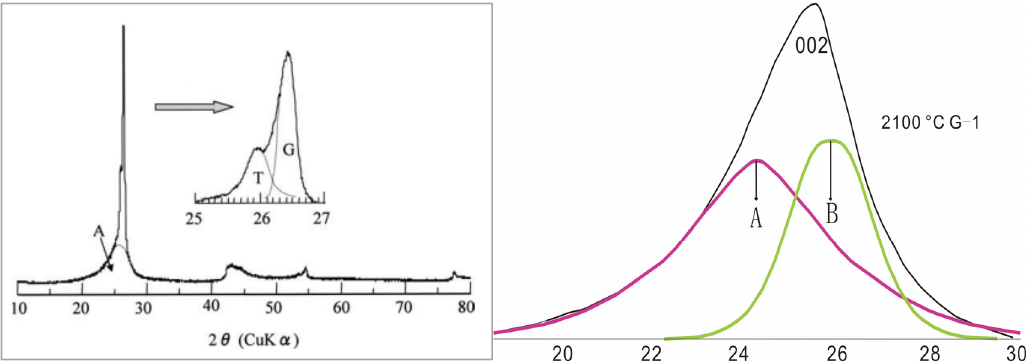
Figure 8. Non-uniform graphitization phenomenon in XRD spectrum (( left ): thermoset resin carbon [43]; ( right ): 2100 °C, G-1).